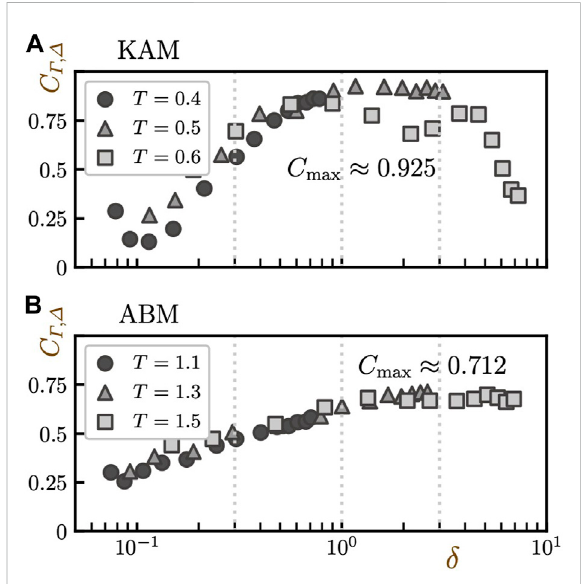
FIGURE 5 The “ time ” evolution of the correlation between Grad-CAM score 1 − Γ and dynamic propensity Δ as a function of the intensity of the cage-relative displacement δ . Results for (A) KAM and (B) ABM. Each simulation was performed for 3 × 10 8 steps, and δ ( t ) during those simulations is plotted on the abscissa for each plot. Different markers are used to distinguish different temperatures as shown in the legend. The vertical dotted lines indicate the delta values visualized in Figures 1,